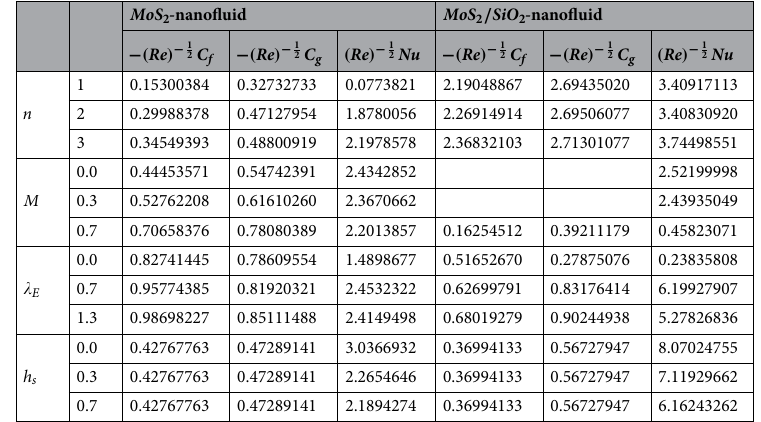
Table 4. Numerical values of velocity gradient, heat and mass fluxes versus n , M , (cid:31) E , K s and Sc when = 0.004, φ = Pr = 204, h s = 1.3, φ 1 2